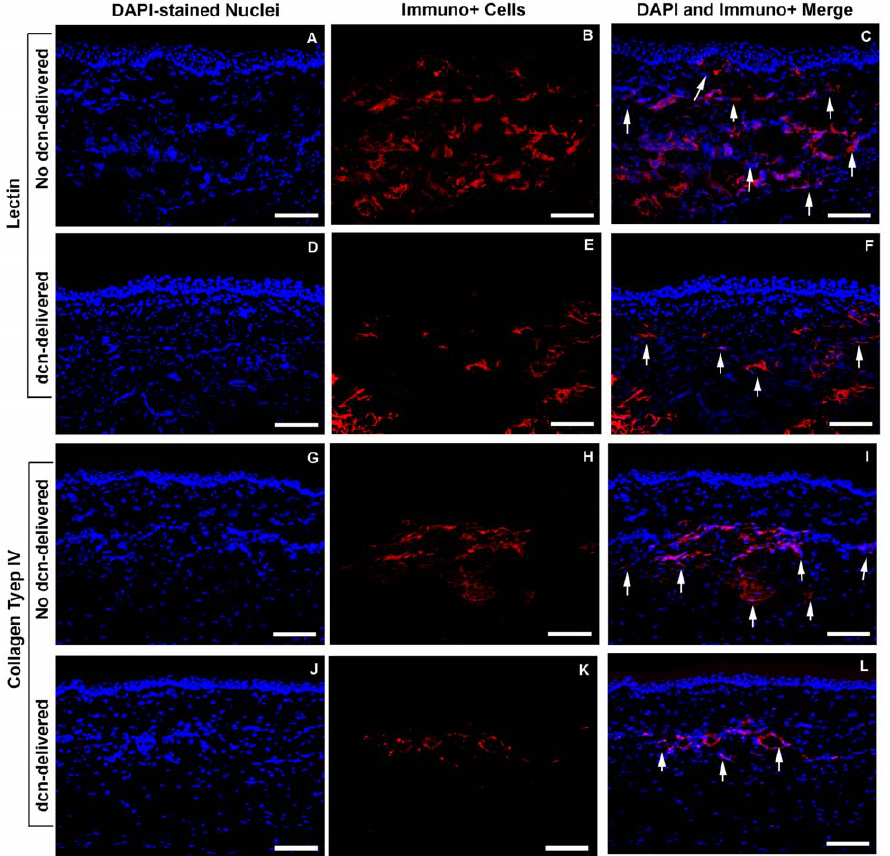
Figure 5. Representative images showing CNV in rabbit corneas treated AAV5 + / 2 decorin. Lectin (A–F) and collagen type IV (G–L) immunostaining was carried out in corneal tissue sections obtained from AAV5-gfp and AAV5-dcn treated rabbit corneas collected 14 days after VEGF implantation. As expected very high lectin (A–C) and collagen type IV (G–I) immunostaining was detected in the corneal sections of AAV5-gfp-treated (no decorin-delivered) corneas due CNV induced by the VEGF implantation. The AAV5-mediated decorin gene therapy significantly reduced (p , 0.01) the CNV as evident from the markedly less lectin + (D–F) and collagen type IV + (J–L) cells in decorin-delivered rabbit corneal sections. DAPI stained nuclei are shown in blue whereas lectin and collagen type IV + cells in red. Scale bar denotes 100 m m. dcn=decorin.